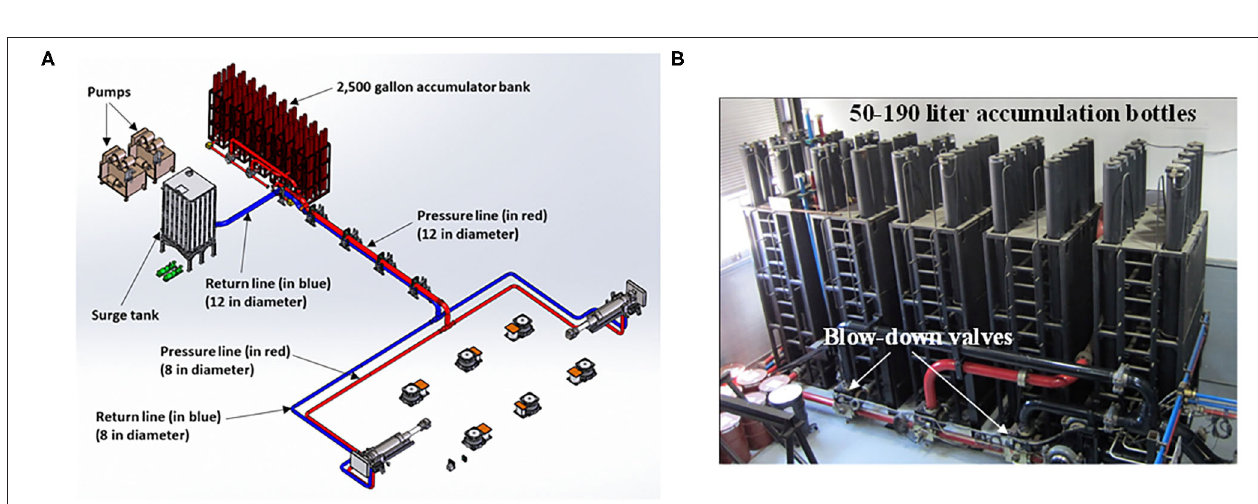
FIGURE 2 | LHPOST in its 1-DOF configuration: (A) Schematic of mechanical and servo-hydraulic components, and (B) picture under bare table condition.